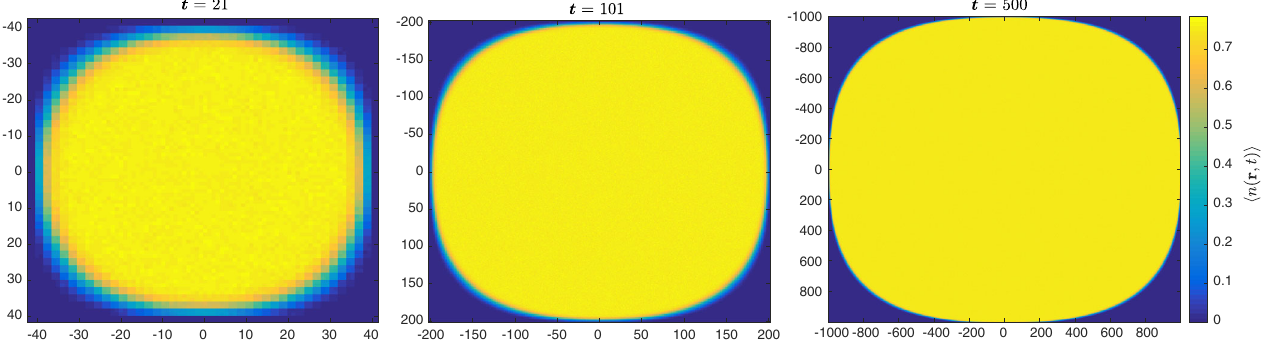
FIG. 7. Growth of a 2D cluster ( q ¼ 2 ): We determine the behavior of the averaged OTOC by simulating the stochastic growth of a two-dimensional cluster over M ¼ 2 × 10 3 realizations, with local updates applied at each time step, as described in the text. The average occupation number for the cluster h n ð x ; t Þi is shown for the indicated times in the evolution as it approaches its asymptotic